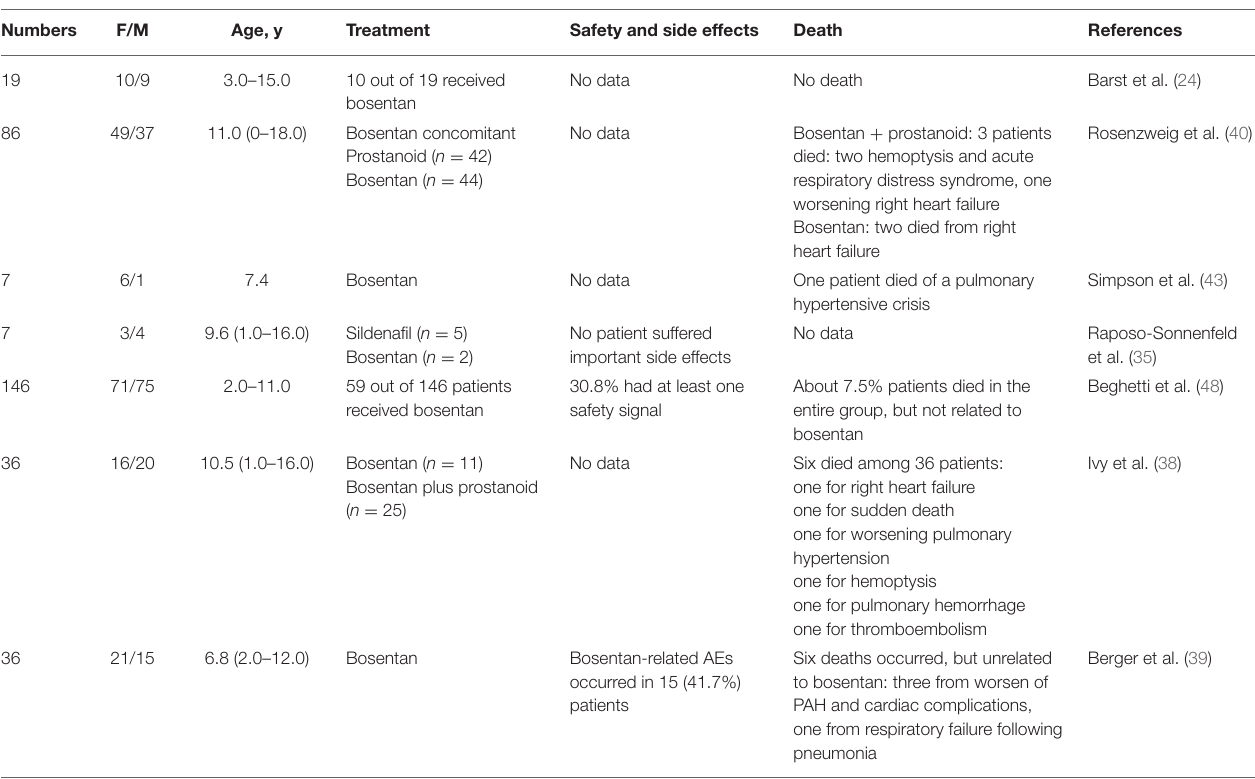
TABLE 5 | Safety and tolerability in pediatric patients treated with